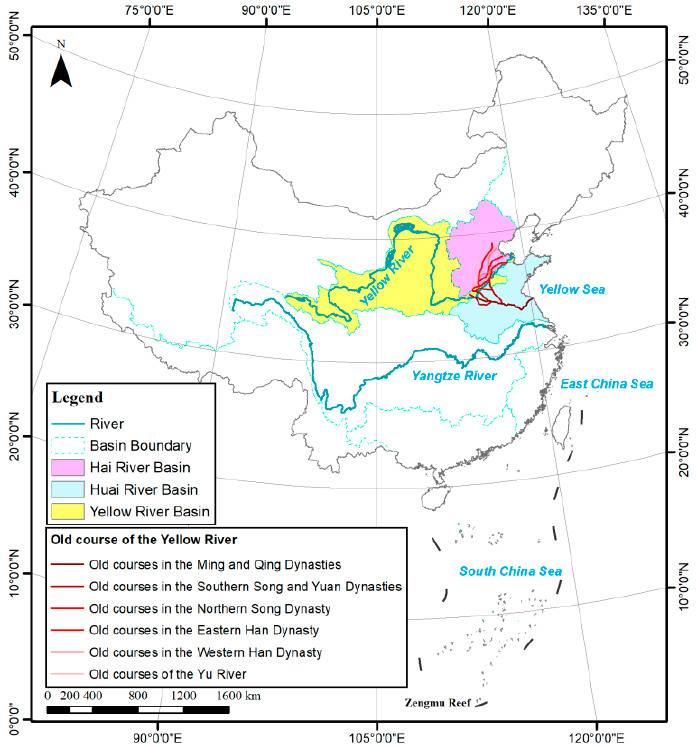
Figure 1. GYRR extent, including the Yellow River Basin, the Huai River Basin, and the Hai River Basin. A similar region concept has been recognized and mentioned by many scholars [40,41].